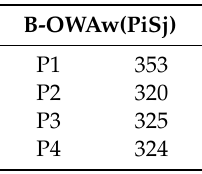
Table 4. Results of the Bonferroni ordered weighted average (B-OWA).